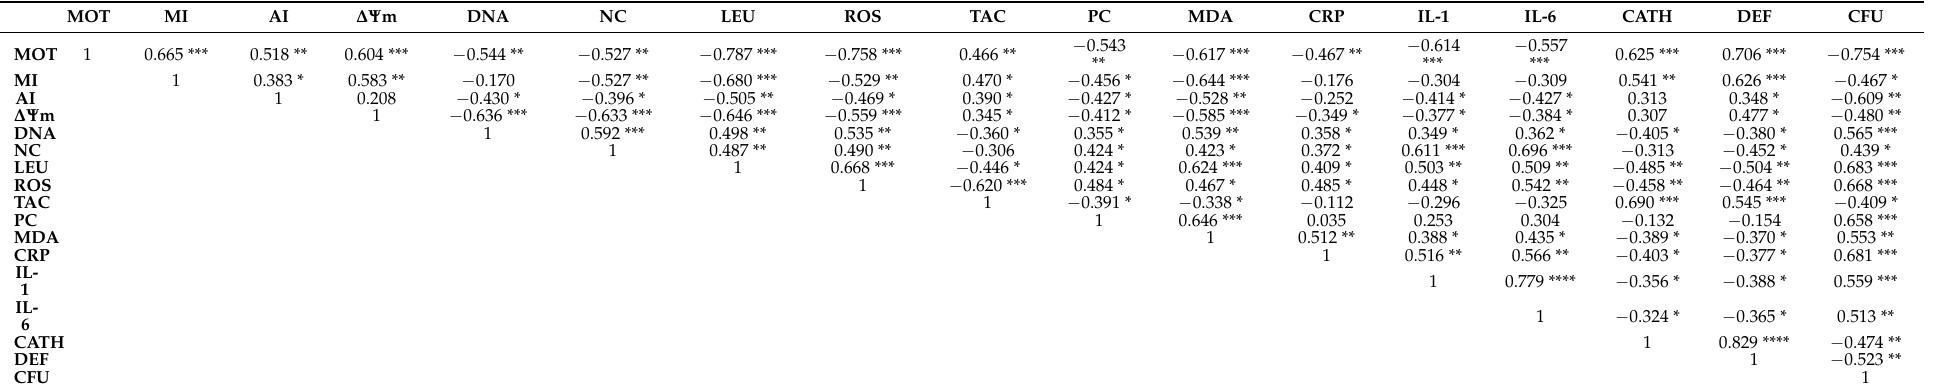
Table 3. Correlations amongst selected semen quality parameters, oxidative, and immunological markers of turkey ejaculates (n =